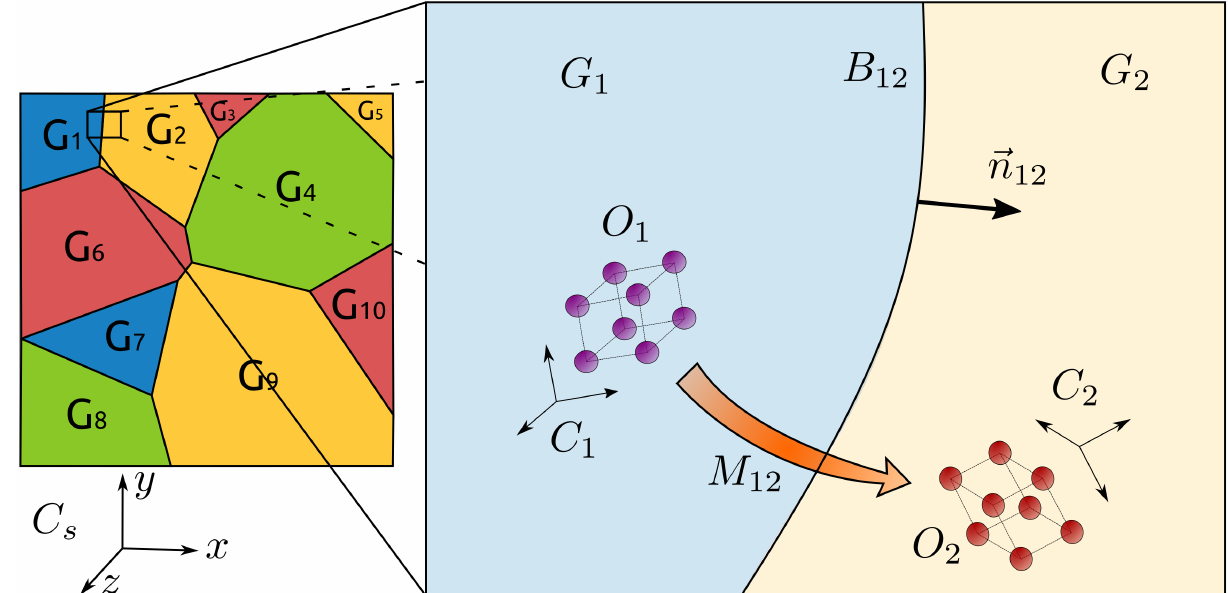
Figure 1. Scheme depicting one GB and its parameters. Image available online at Flickr (https://flic.kr/p/2m5JQkz, Uploaded on 15 June 2021) licensed under CC BY 2.0 (https://creativecommons.org/licenses/by/2.0/, Uploaded on 15 June 2021). Title: 10GGBParam. Author: Brayan